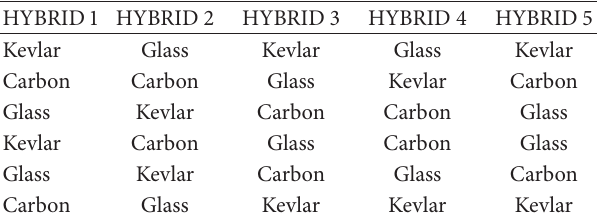
Table 1: Fabricated composite plates were divided into five groups (from top surface to bottom surface) [17,